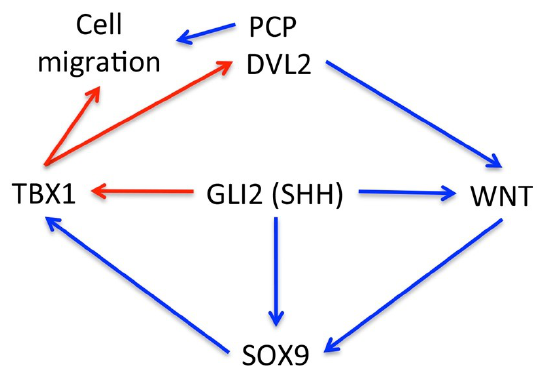
Figure 6. Schematic of the proposed regulatory role of TBX1 in BCC. Interactions already established are shown in blue [12,16,21], those proposed here are shown in